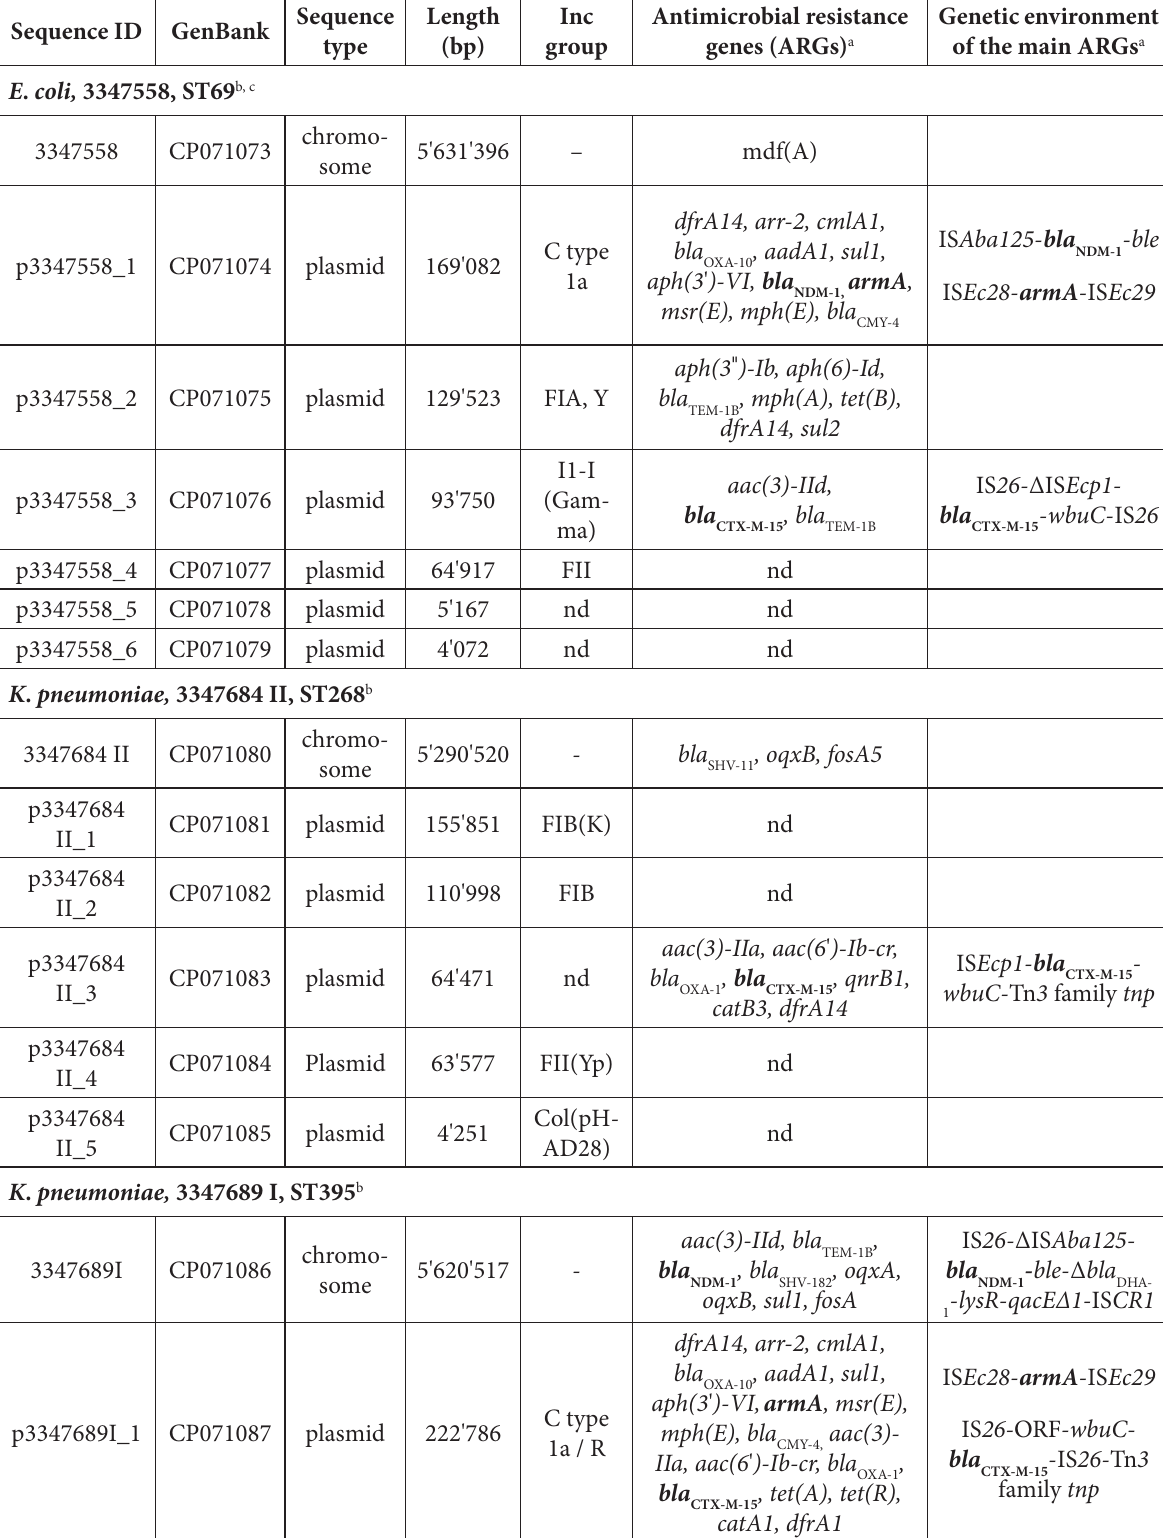
Table 3. Molecular characterization of the 5 Enterobacterales isolated from the same patient Sequence